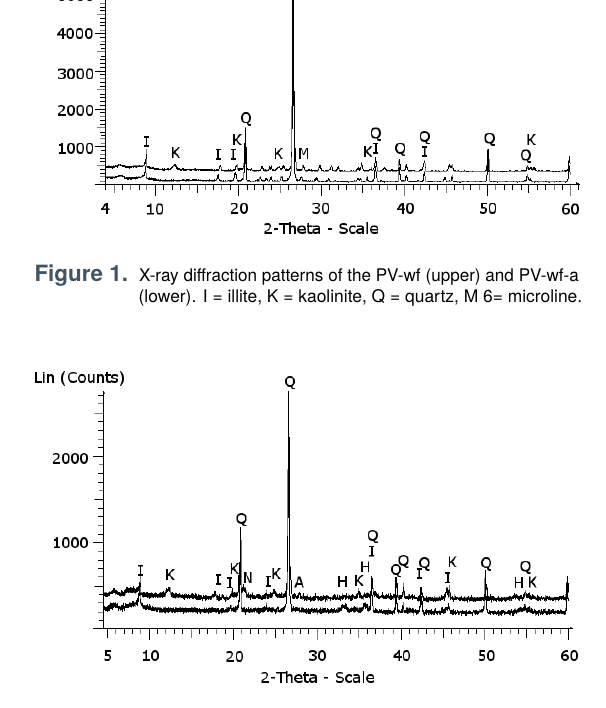
Figure 2. X-ray diffraction patterns of the PM-wf (upper) and PM-wf-a (lower). I = illite, K = kaolinite, Q = quartz, N = nacrite, A = anorthite, H =